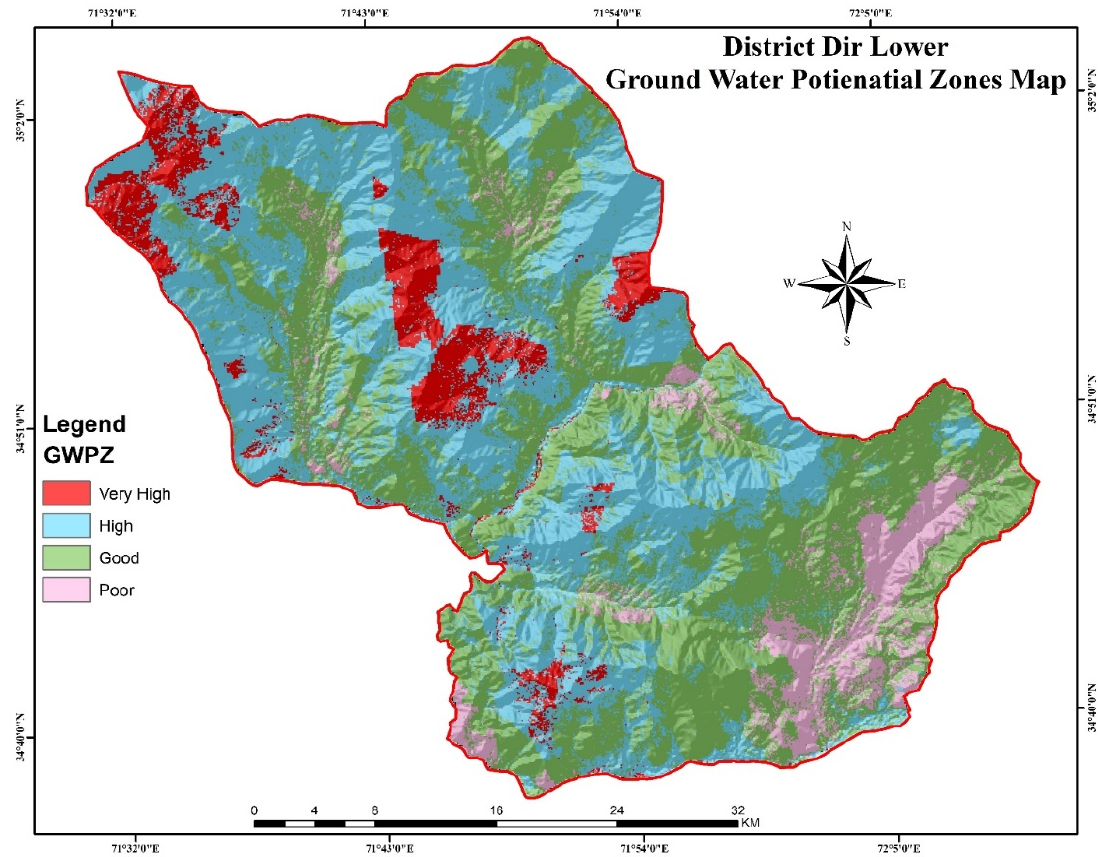
Figure 6. Delineated groundwater potential zones in Lower Dir District, Khyber Pakhtunkhwa, Pakistan.